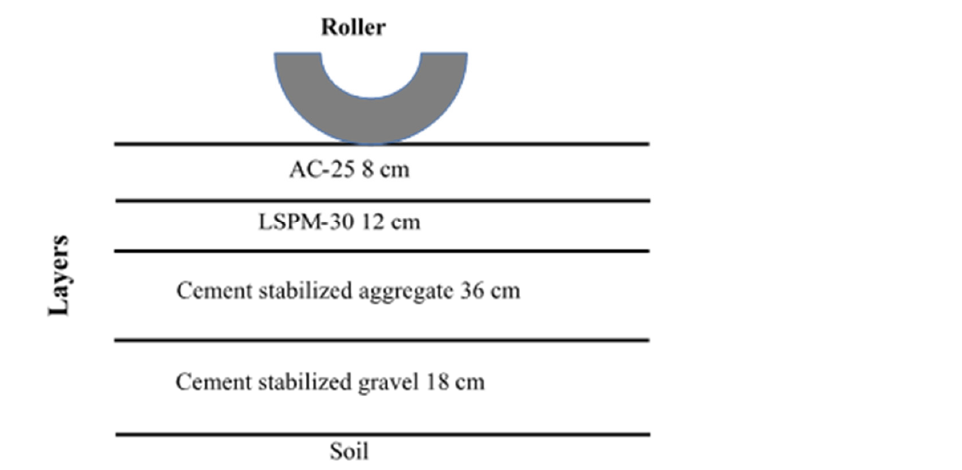
Appl. Sci. 2021 , 11 , x FOR PEER REVIEW Figure 1. Pavement structure cross ‐ section of compaction test. Figure 1. Pavement structure cross-section of compaction test.